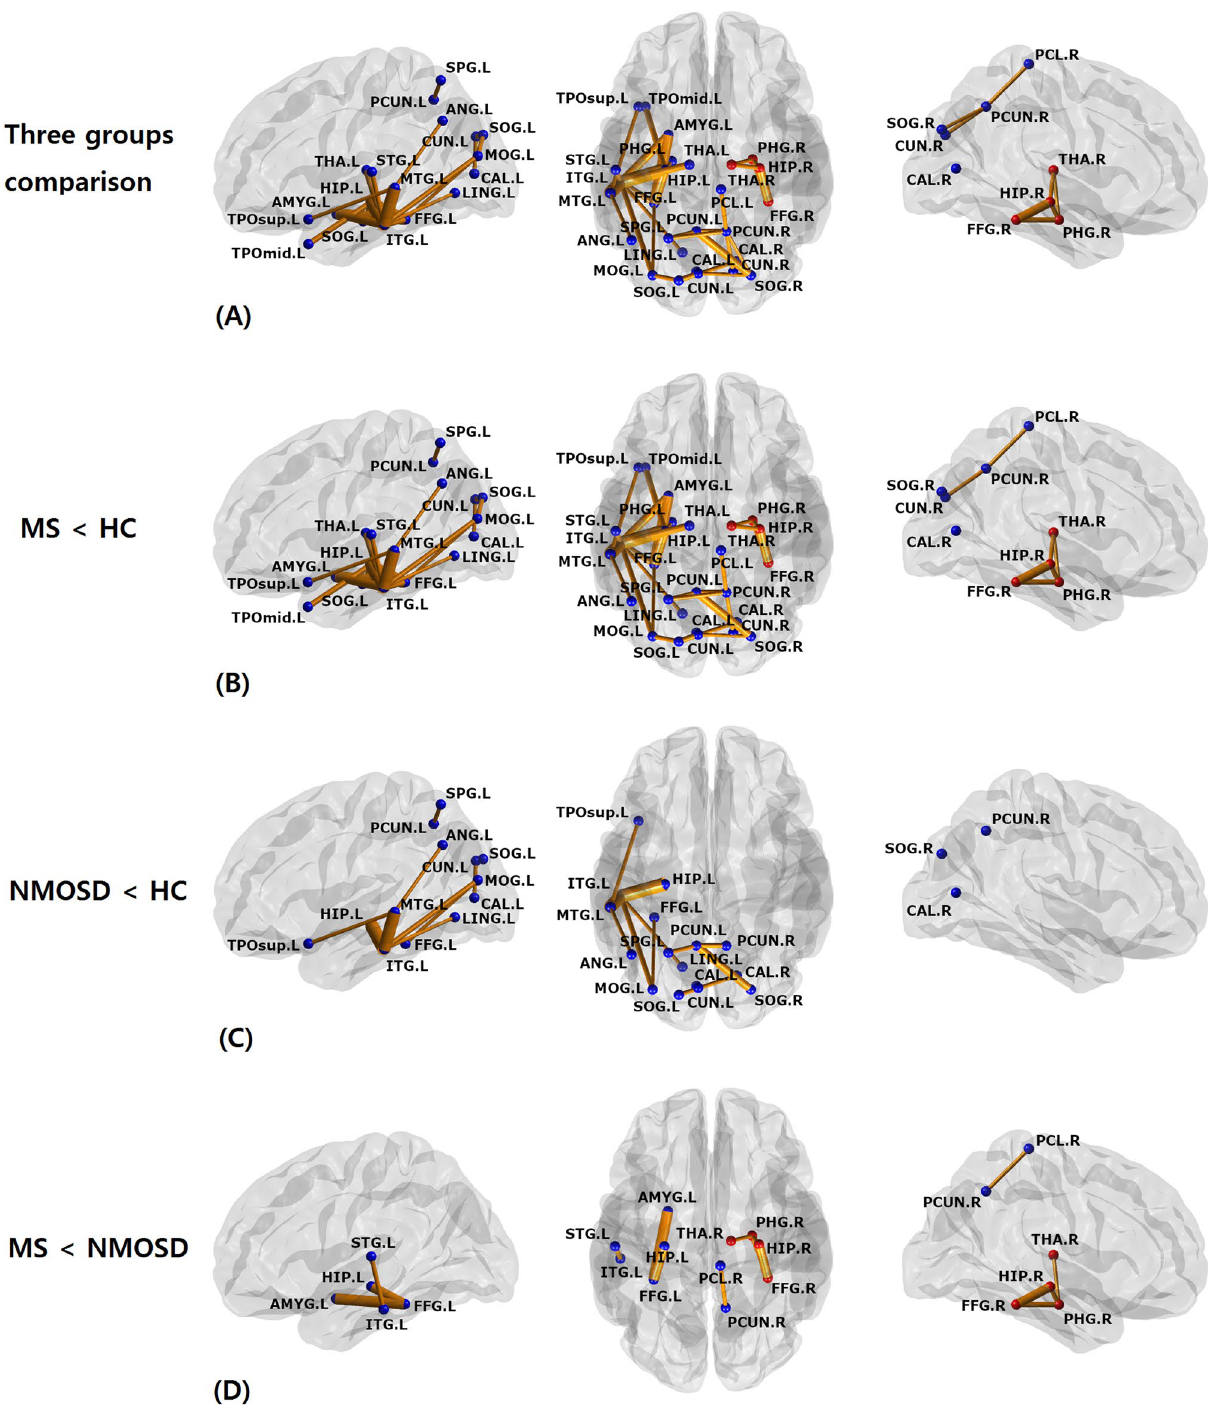
Figure 1. The two disrupted subnetworks in the multiple sclerosis (MS) and neuromyelitis optica spectrum disorder (NMOSD) groups as identified through network-based statistics. Significantly different connections between ( A ) three groups (MS, NMOSD, healthy controls [HC]), ( B ) MS and HC, ( C ) NMOSD and HC, and ( D ) MS and NMOSD were displayed; each edge was disrupted in MS or NMOSD compared with HC and there were no edges with increased edge weights in NMOSD compared with MS. The left column displays the lateral view of the left hemisphere, the middle column displays the transverse views of both hemispheres, and the right column displays the lateral view of the right hemisphere. The blue and red circles are the brain regions of subnetworks 1 and 2, respectively. The orange lines are the edges that connect each region. HIP hippocampus, PHG parahippocampal gyrus, AMYG amygdala, CAL calcarine fissure, CUN cuneus, LING lingual gyrus, SOG superior occipital gyrus, MOG middle occipital gyrus, FFG fusiform gyrus, SPG superior parietal gyrus, ANG angular gyrus, PCUN precuneus, PCL paracentral lobule, THA thalamus, STG superior temporal gyrus, TPOsup temporal pole: superior temporal gyrus, MTG middle temporal gyrus, TPOmid temporal pole: middle temporal gyrus, ITG inferior temporal